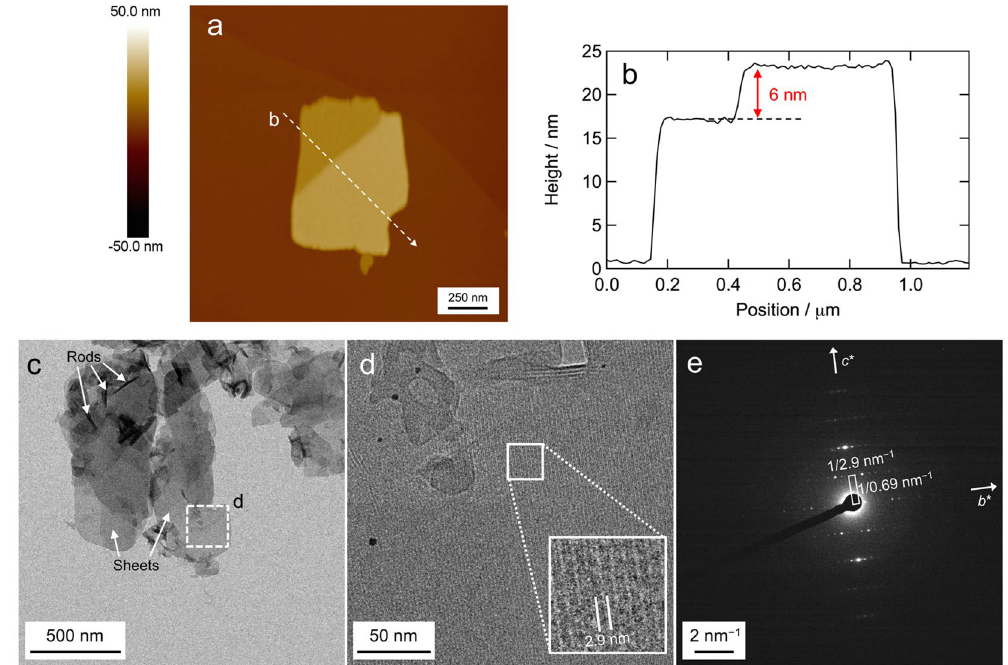
Figure 3. Supramolecular nanosheets of Zn-2 self-assemblies formed upon standing in THF/hexane (5:95, vol/ vol) for one week. Tapping-mode AFM analysis of Zn-2 J -aggregates on an HOPG substrate, ( a ) AFM height image and ( b ) cross-section analysis. Cryo-TEM analysis of Zn-2 on a carbon-coated copper grid, ( c ) and ( d ) cryo-TEM images and ( e ) electron beam